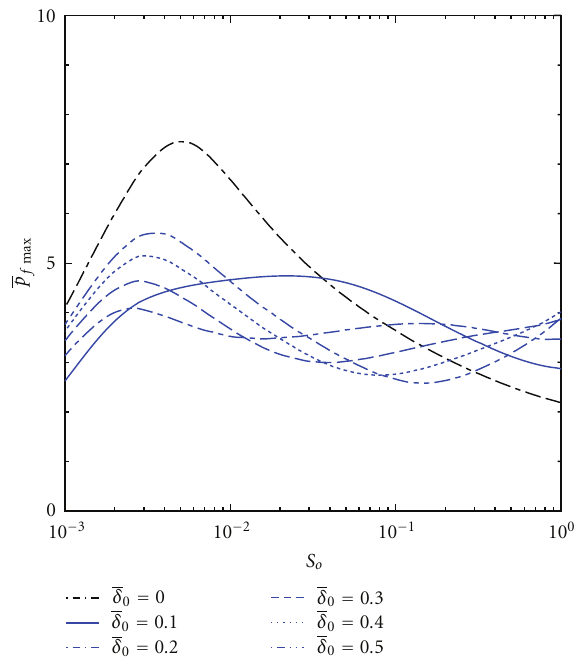
Figure 7: E ff ect of dent δ o on maximum fluid pressure p